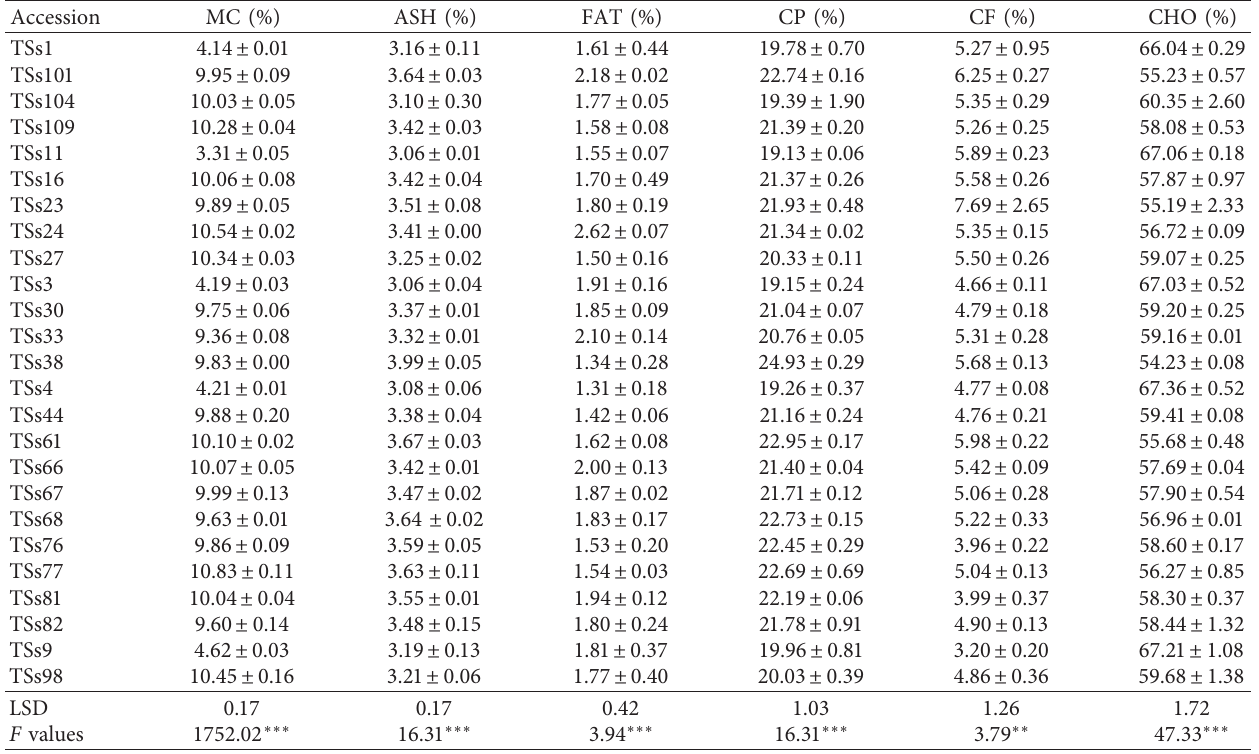
Table 3: Proximate composition (mean ± standard deviation) of unprocessed